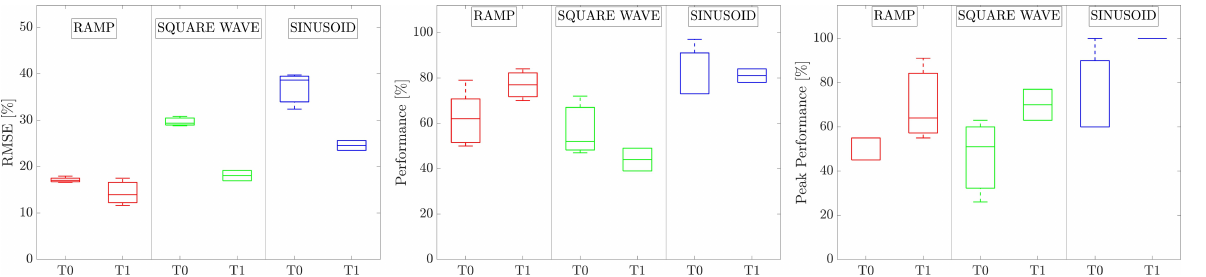
Figure 10. Normalized RMSE expressed as a percentage of the maximum force, P, and PP of the patient for each waveform. The middle line is the median computed for the executed repetitions of each waveform, the edges of the box are the 25th and 75th percentiles, and the whiskers extend to the most extreme data points not considered